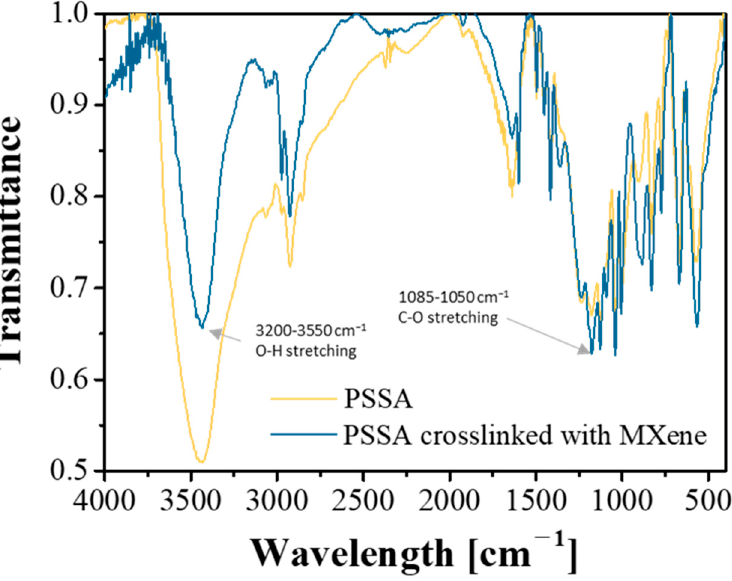
Figure 2. Fourier-Transform infrared spectroscopy spectra of the poly(4-styrenesulfonic acid) (PSSA) and PSSA crosslinked with MXene solution.